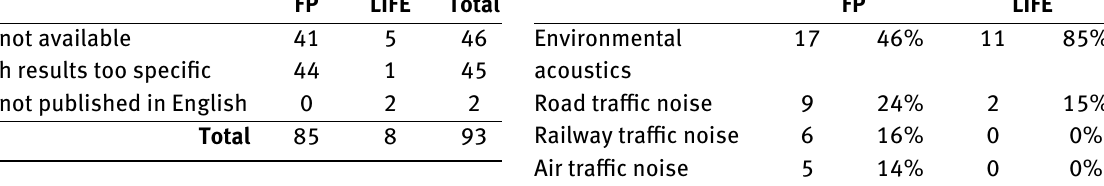
Table 4: Distribution of projects included in the review. FP